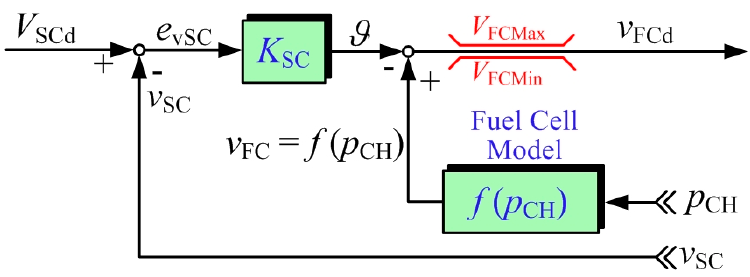
Figure 12. Control scheme of the production of the desired FC voltage v FCd and the algorithm of the charging SC energy storage unit.